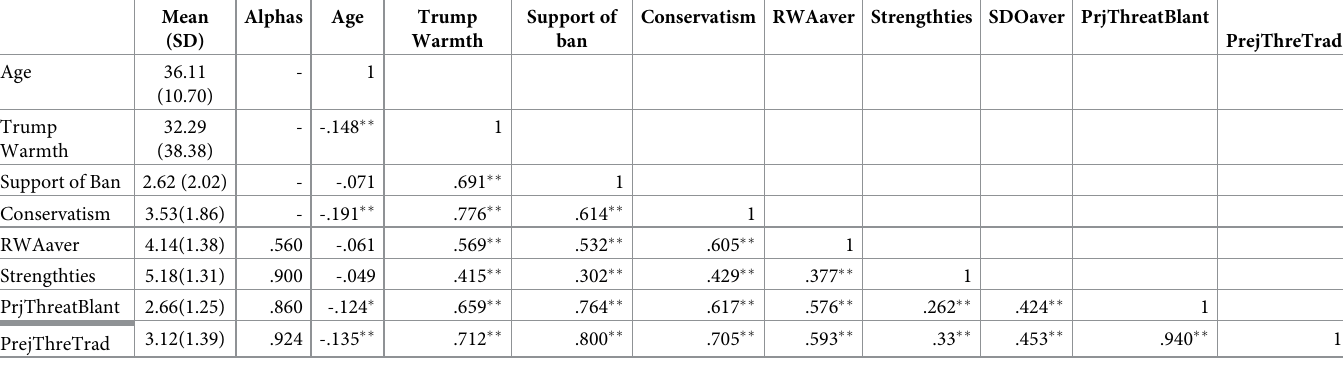
Table 1. Descriptive statistics and